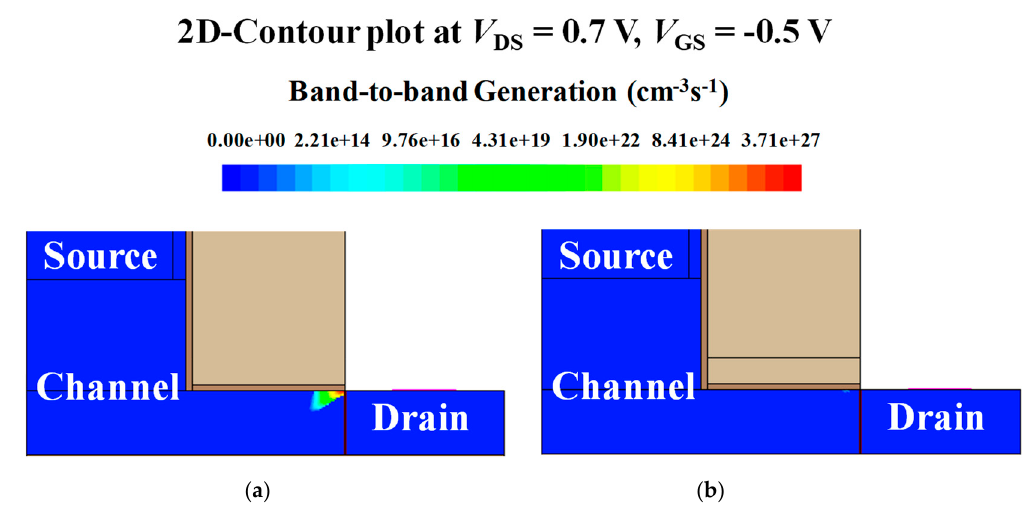
Figure 3. 2-D contour plot of band-to-band tunneling (BTBT) generation for ( a ) single gate and ( b ) stacked gate L-shaped TFET. Ambipolar current suppression is observed from the decreased BTBT rates in the stacked gate L-shaped TFET.